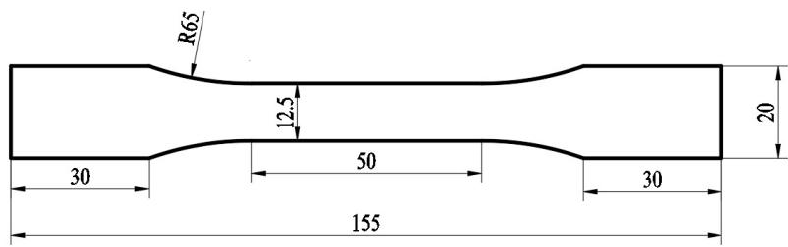
Figure 1. Specimen size of tensile and fatigue test (unit: mm).